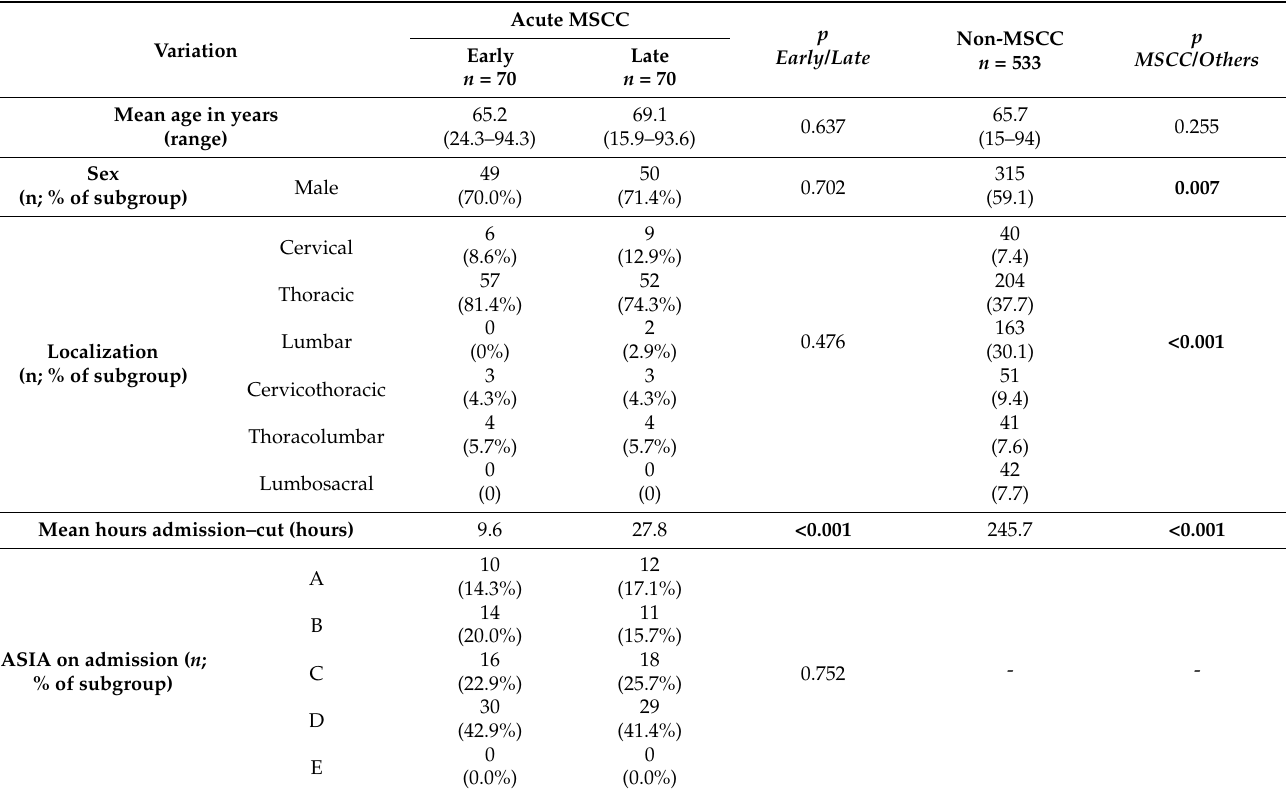
Figure 1. Flow chart illustrating patient groups. Bold type denotes subgroup with acute MSCC used for primary analyses. SM, spinal metastasis; MSCC, metastatic spinal cord compression. Table 1. Baseline characteristics of both the non-MSCC as well as the acute MSCC groups. Early and late subgroups within acute MSCC defined by surgery within or after the median time from admission to surgery; N—number; p —level of significance; bold typeface denotes statistically significant difference.